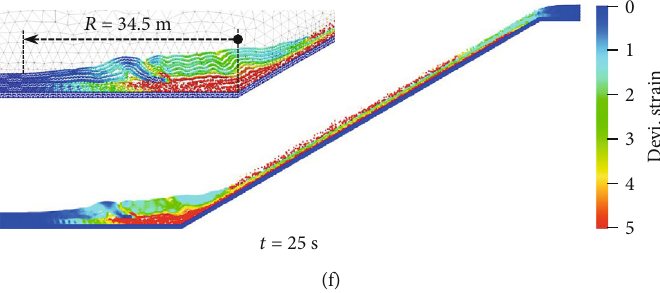
Figure 13: E ff ect of soil friction angle on the postfailure behavior of a slope: (a – c) ϕ ′ = 25 o and (d – f) ϕ ′ = 37 o